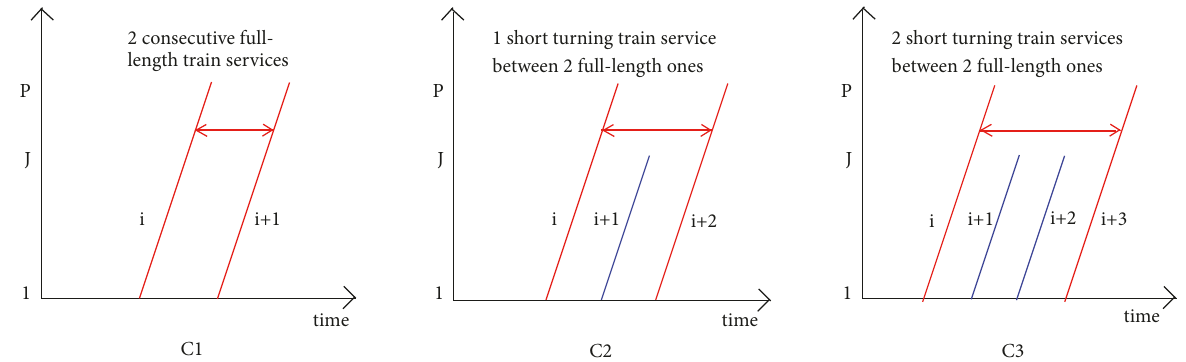
Figure 7: Possible combinations of short turning and full-length train services in the up